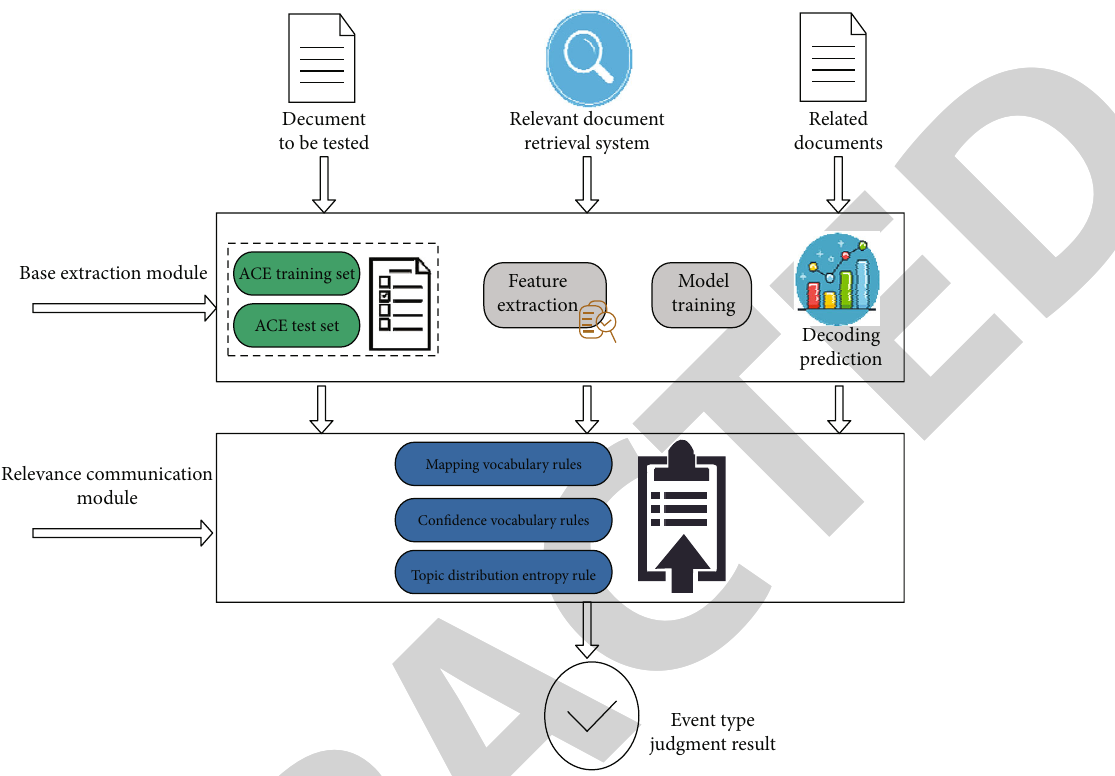
Figure 2: The framework of the event extraction decision scheme of the neural network hybrid